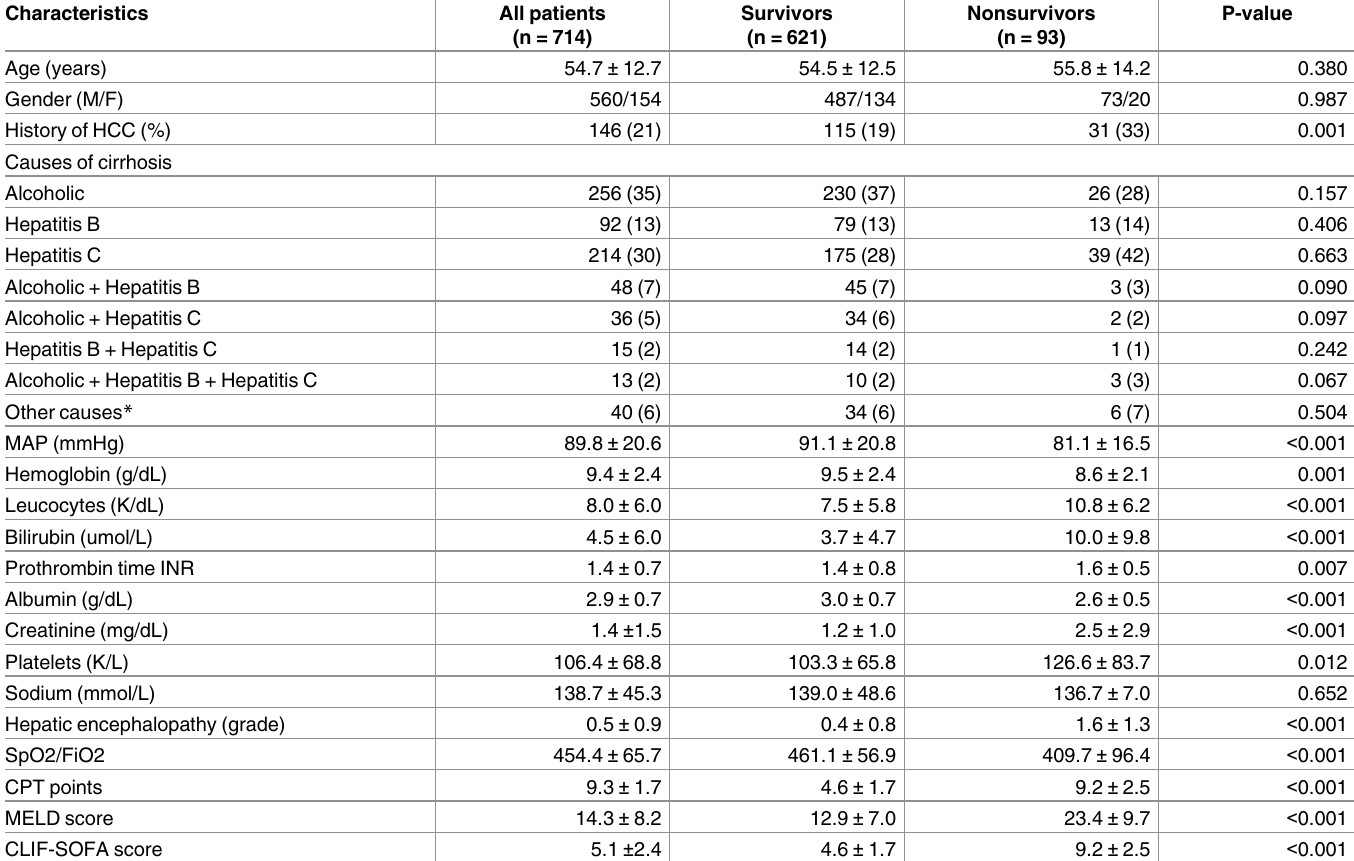
Table 1. Demographical and clinical characteristics according to 6-week